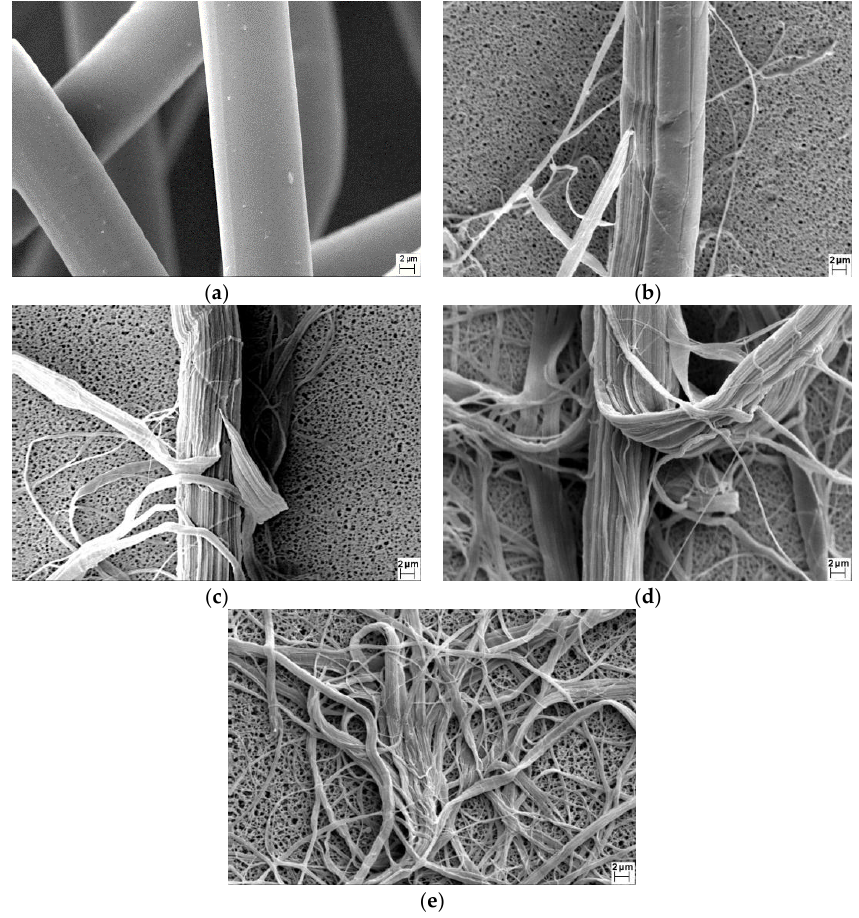
Figure 4. SEM images of fibrillated Lyocell fiber under a different number of revolutions: ( a ) original Lyocell fiber; ( b ) 5000 revolutions; ( c ) 10,000 revolutions; ( d ) 20,000 revolutions; ( e ) 40,000 revolutions.